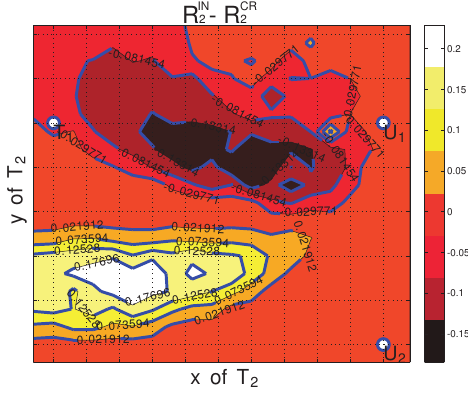
Figure 4: Difference between maximum achievable secondary rates with CR and pure CJ R CR a function of the position of T 2 .